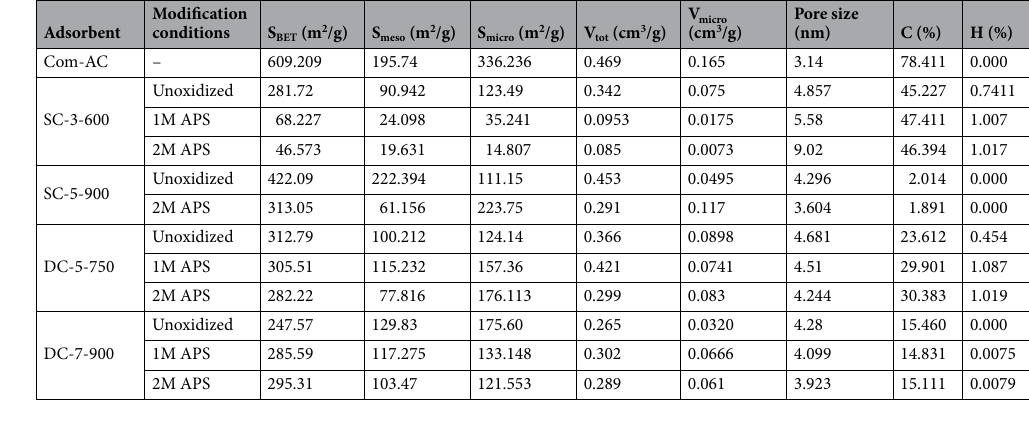
Table 6. Structural properties and ultimate analysis results of SBAC after and before